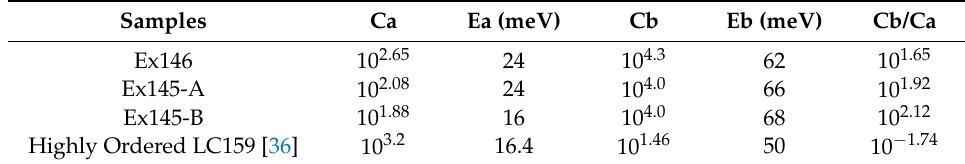
Figure 2. Temperature dependence of photoluminescence (PL) peak intensity for: ( i ) Ex145-B; ( ii ) Ex145-A; and ( iii ) Ex146. Table 2. Activation energy for GaInP epitaxial layers.